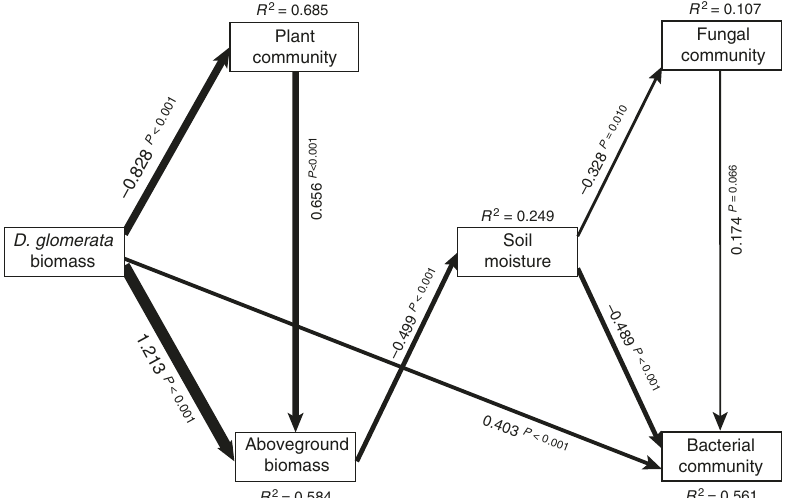
Fig. 8 Structural equation model of relationships between D. glomerata biomass, plant community attributes and microbial properties, at the fi nal, late recovery sampling. For each signi fi cant relationship, standardised coef fi cient and P values are given alongside arrow, and arrow weights are proportional to standardised coef fi cients. The model fi t the data well: P = 0.345, CFI = 0.995, P RMSEA< = 0.05 = 0.439